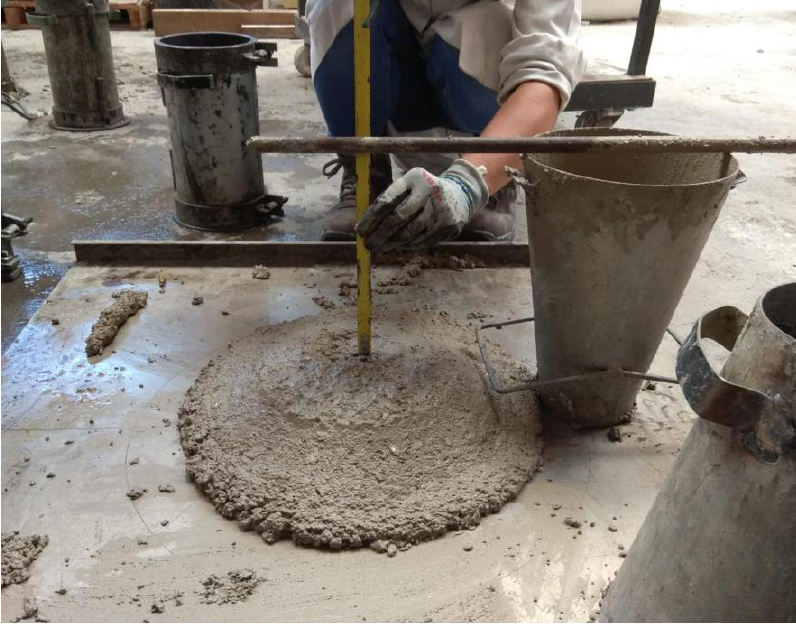
Figure 6. Measuring the height of the Abrams cone test.